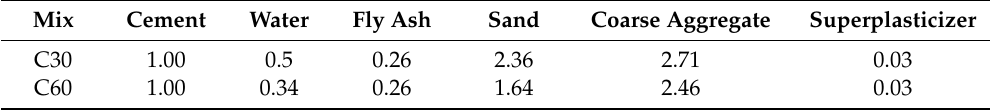
Table 1. Mixing proportion (relative weight ratios to